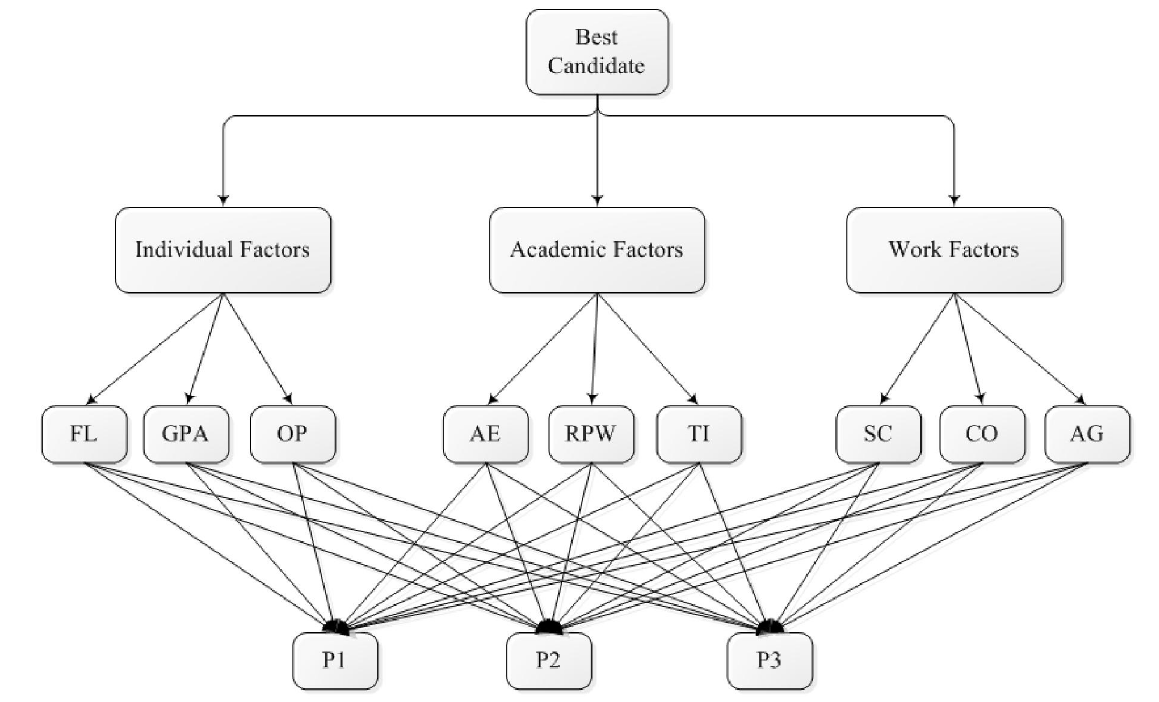
Fig. 2. The hierarchy of the